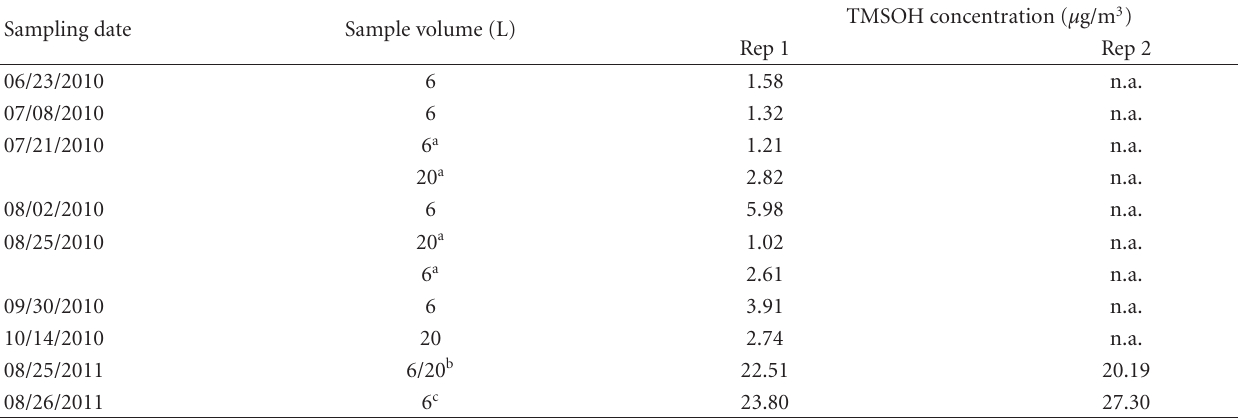
Figure 4: Total ion chromatograms of a typical field sample collected in a semiconductor fabrication workshop. Notes: IPA: Isopropyl alcohol; PGME: Propylene glycol methyl ether; PGMEA: Propylene glycol monomethyl ether acetate; L2: Hexamethyldisiloxane; D3: Hexamethylcyclotrisiloxane; D4: Octamethylcyclotetrasiloxane; D5: Decamethylcyclopentasiloxane. Table 3: TMSOH concentrations measured in a semiconductor fabrication